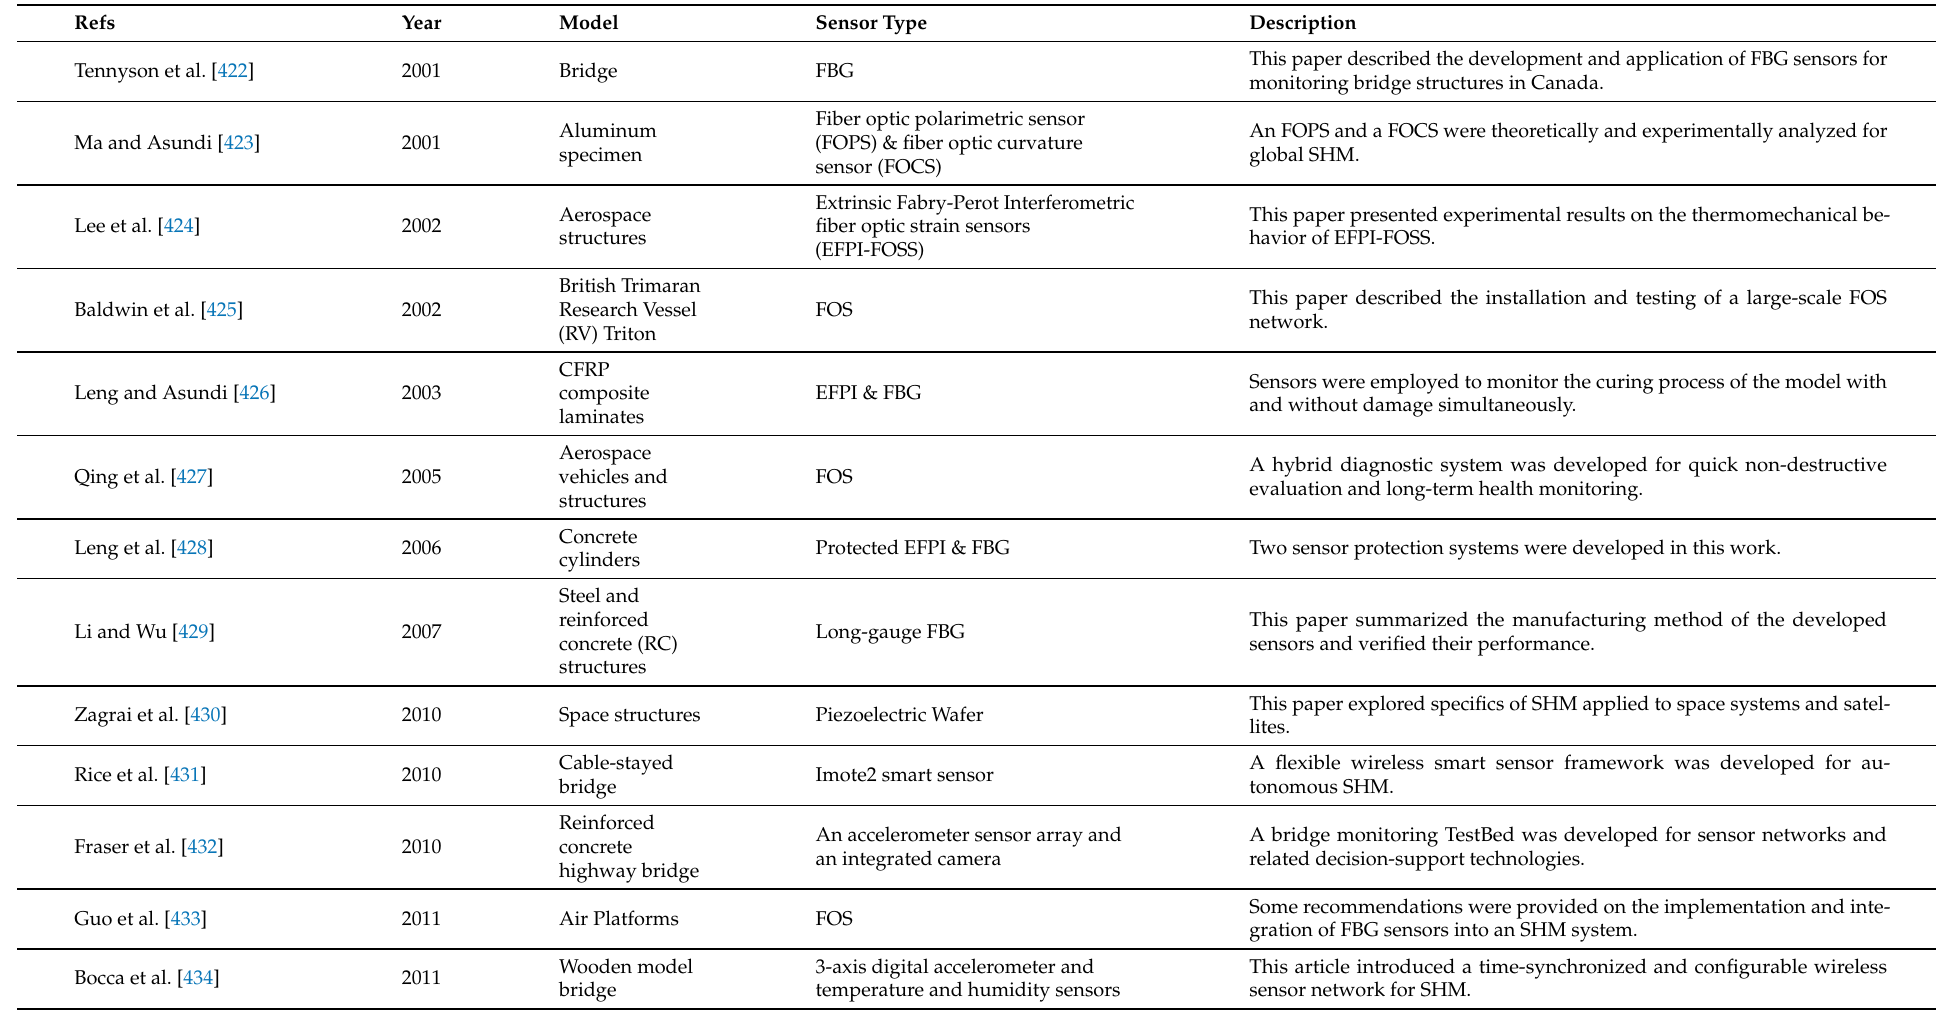
Table 26. Review of some recent papers on the application of advanced sensors in